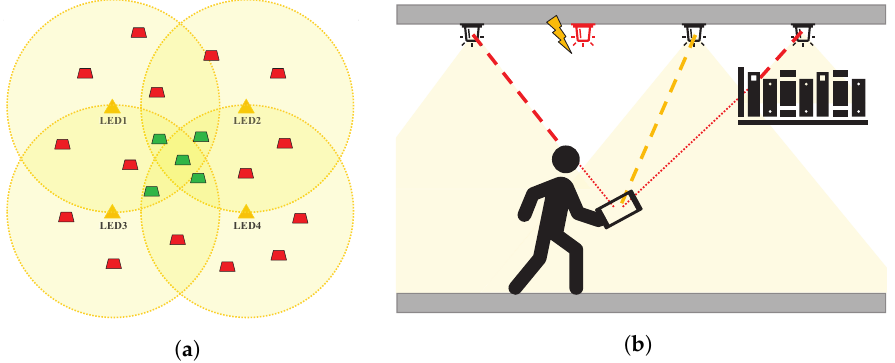
Figure 1. Structural problem of general multiple signal-based VLP systems: ( a ) problems caused by restrictions on viewing angles and ( b ) problems caused by obstacles, failures,